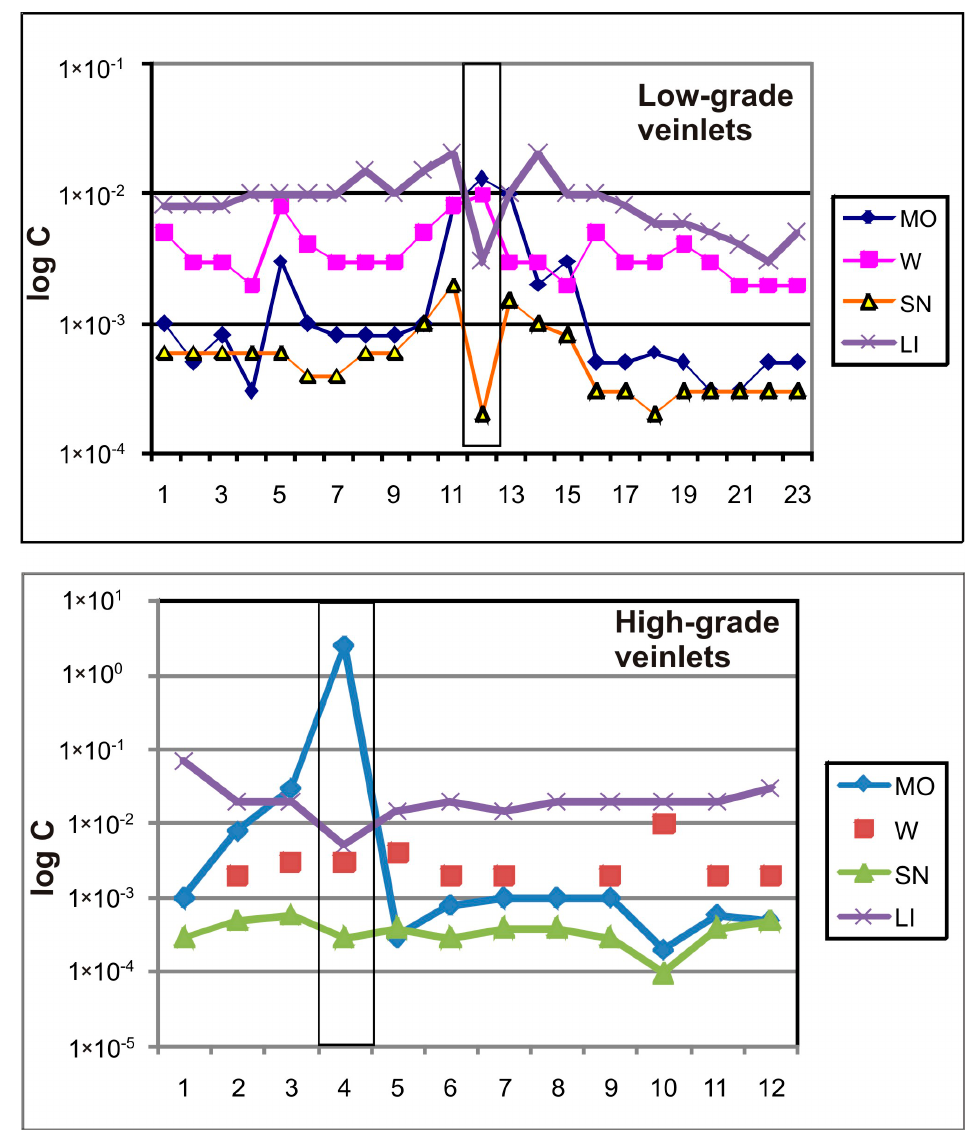
Figure 7. Distribution of some elements near the quartz-molybdenite veinlets (rectangles) of two types. The horizontal axis shows the sample numbers; C—concentrations in wt. %.